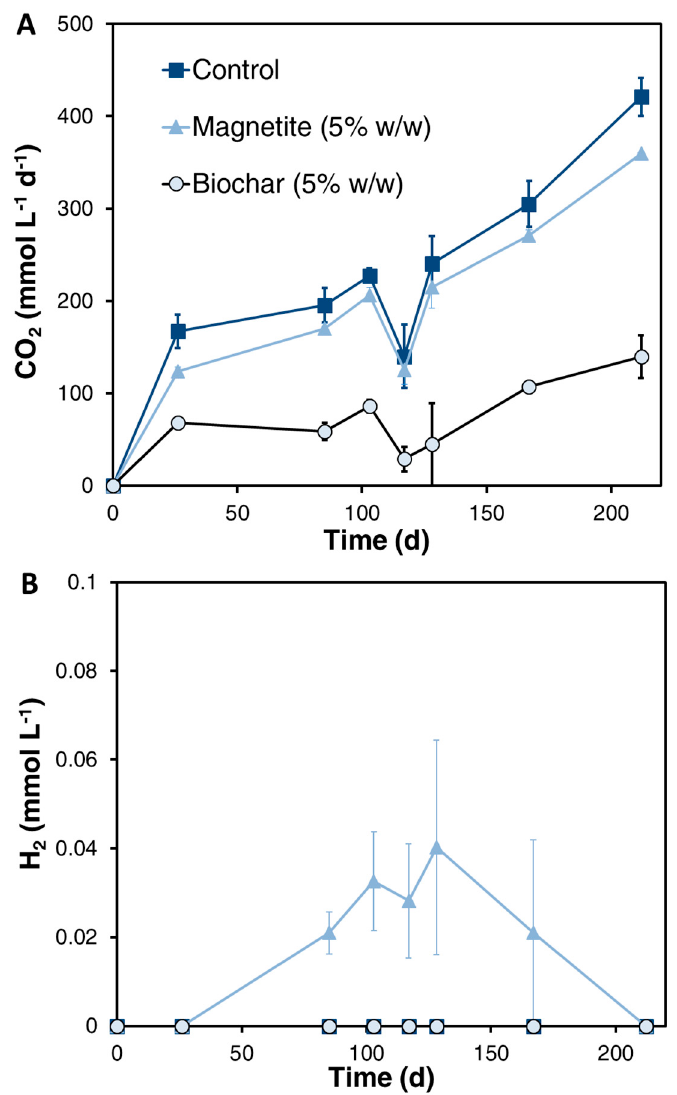
Figure 6. Time course of CO 2 ( A ) and H 2 ( B ) concentration in the headspace of the different micro- cosms during the whole experimental period. Error bars represent the SE of replicated samples.